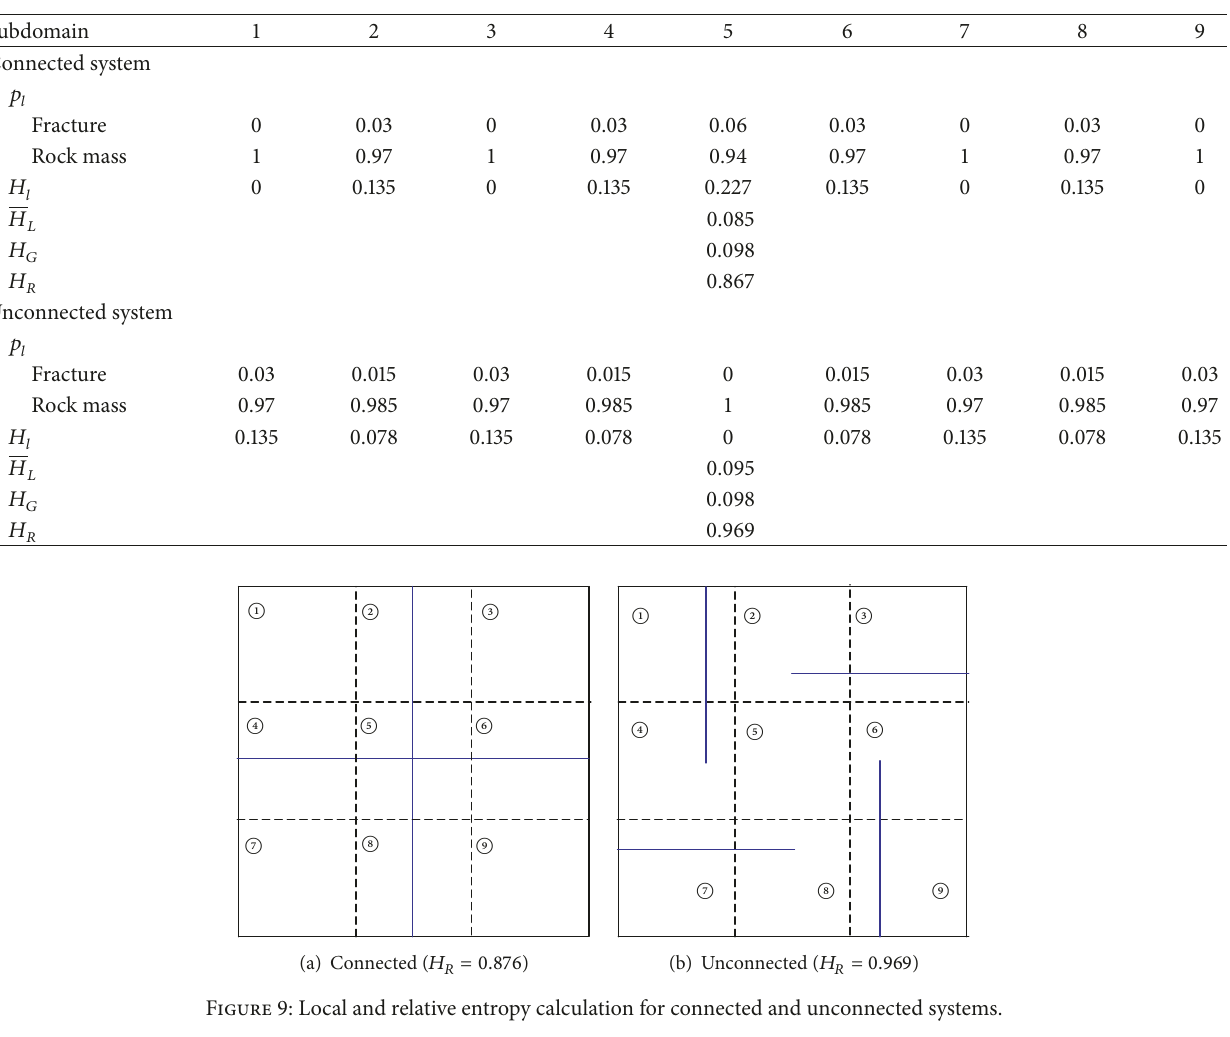
Table 2: Parameters of the geological entropy for connected and unconnected systems.